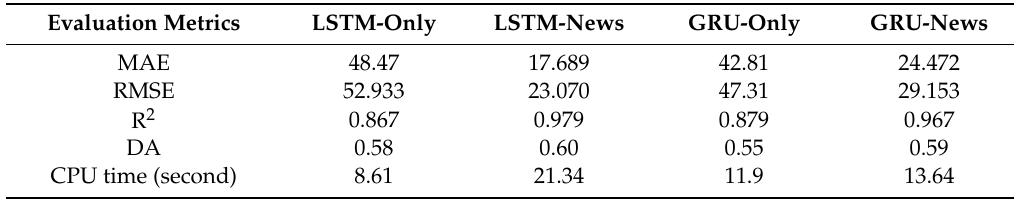
Table 5. Summary of